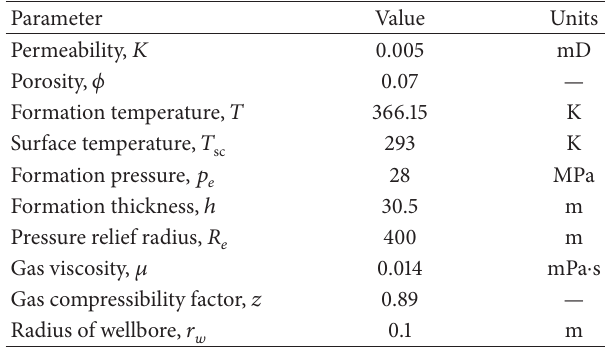
Table 3: Data of shale gas reservoir for production simulation.